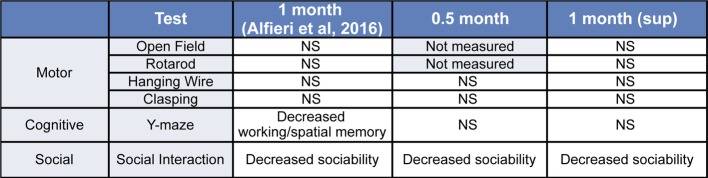
Summary of the behavioral phenotypes observed in tTA/WT12 mice after 0.5 or 1 month (from Alfieri et al., 2016) of hTDP-43 expression and in the 1 month (sup) group. NS: non-significant differences respective to control mice.